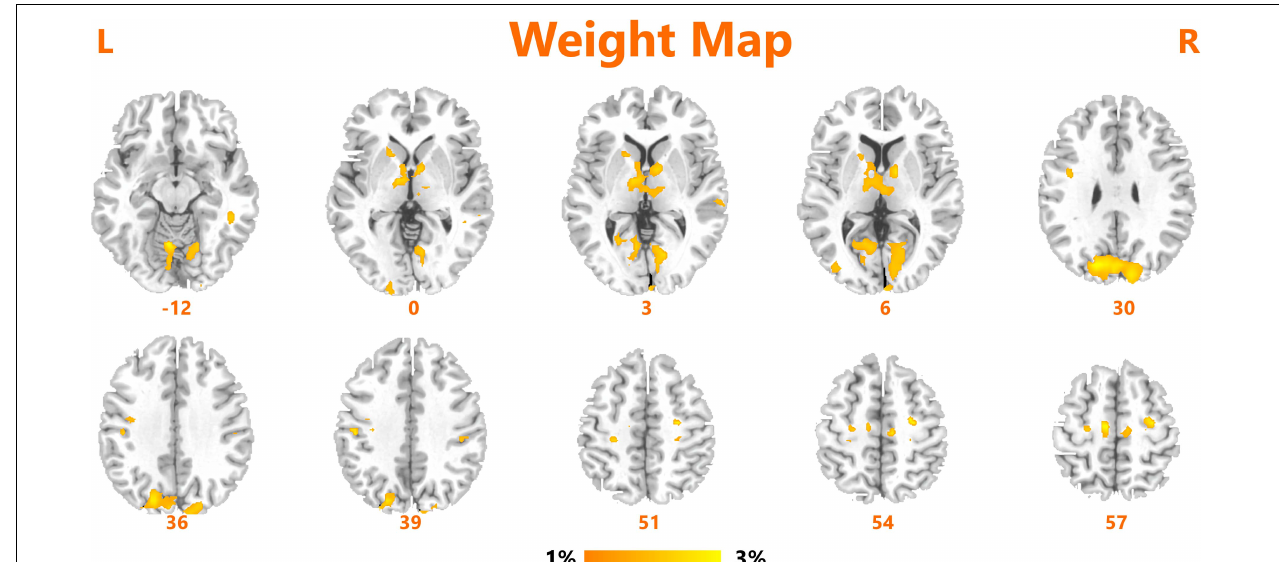
FIGURE 3 | Brain regions of interest that contributed mostly to the accurate classification.